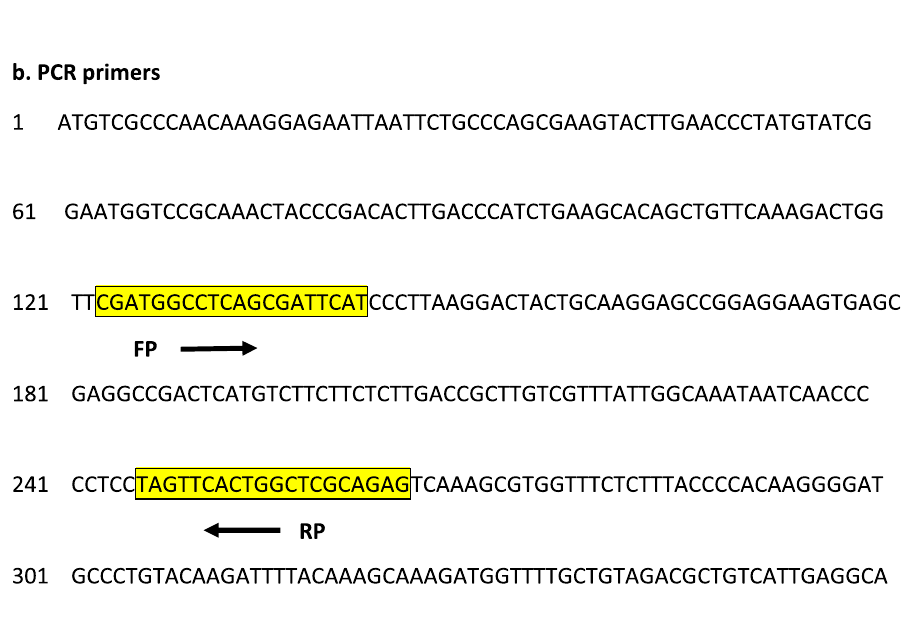
Figure 1. Schematic representation of position and sequence of the designed primer sets within the nucleotide sequence of the putative effector gene of Fusarium oxysporum f. sp. ciceris used for ( a ) LAMP and ( b ) PCR